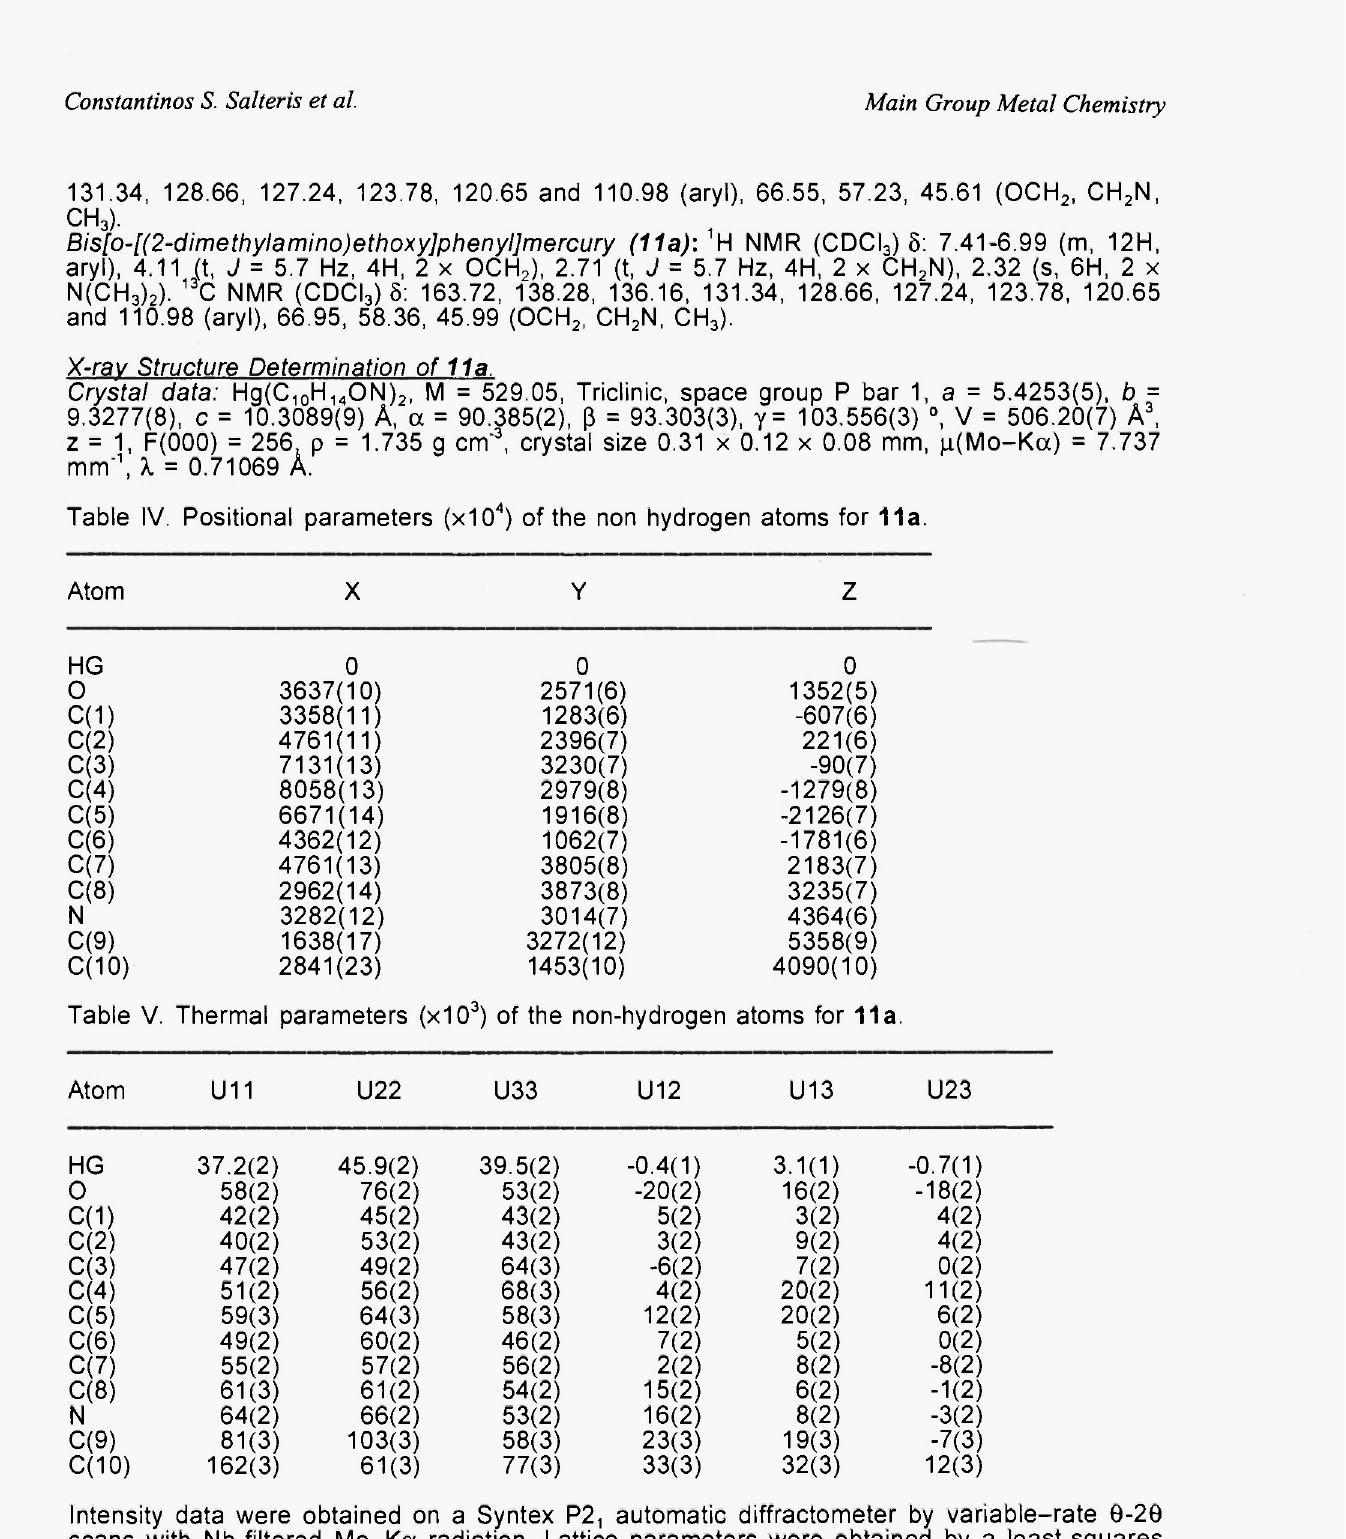
Table V. Thermal parameters (x10 3 ) of the non-hydrogen atoms for